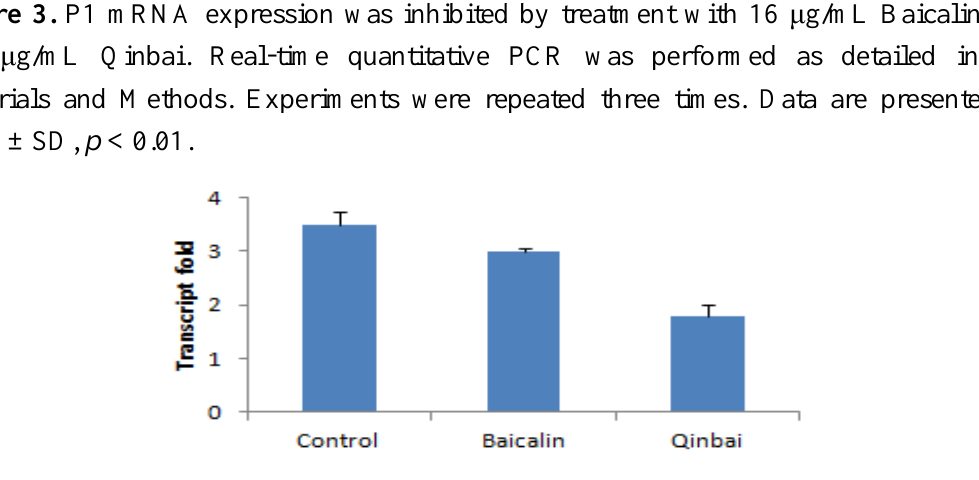
Figure 3. P1 mRNA expression was inhibited by treatment with 16 μg/mL Baicalin and 100 μg/mL Qinbai. Real-time quantitative PCR was performed as detailed in the